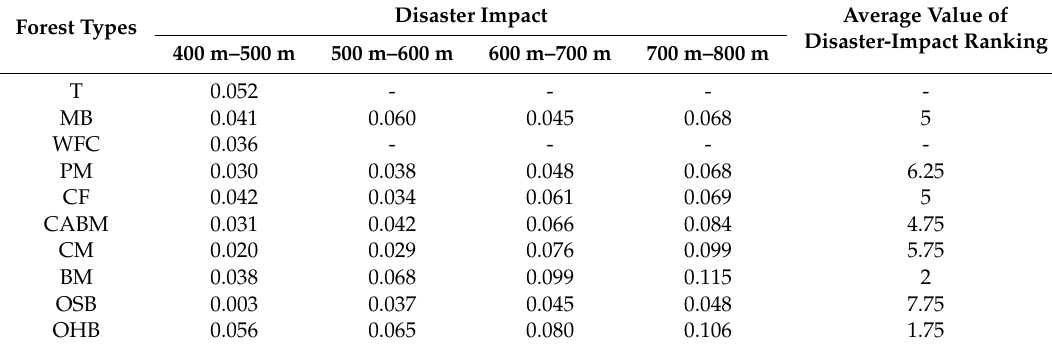
Table 9. Post-disaster recovery and fluctuation degree analysis results for different forest types in four elevation zones.